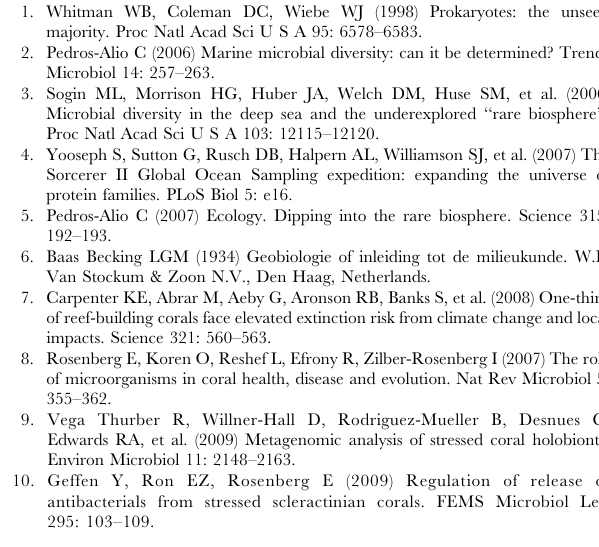
Table S1 Re-sampled V6-tag abundances in coral samples and reef